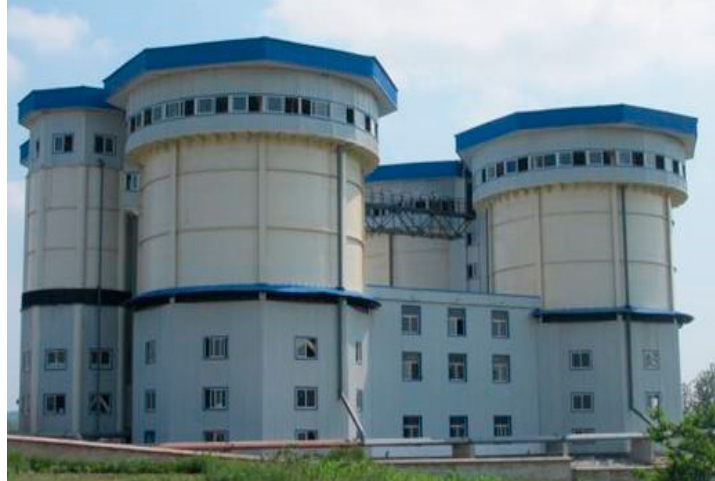
Figure 1. The filling plants of the Lilou iron mine.